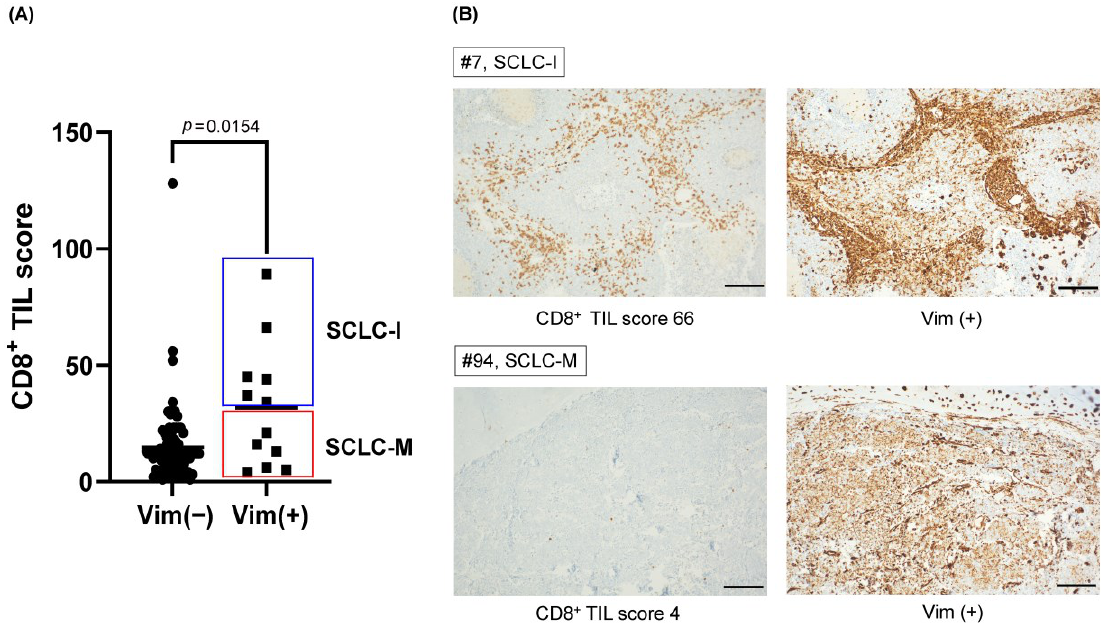
Figure 4. The prevalence of SCLC-M subtype in primary SCLC tumor cohort. ( A ) Mean CD8+ TIL scores of vimentin (+) tumors and vimentin ( − ) tumors. CD8+ TIL score of vimentin (+) tumors divided into SCLC-I and SCLC-M subtypes. ( B ) Representative immunohistochemical stains of CD8+ TIL high/Vimentin (+) (SCLC-I) and CD8+ TIL low/Vimentin (+) (SCLC-M) tumors. (scale bar; 100 µ